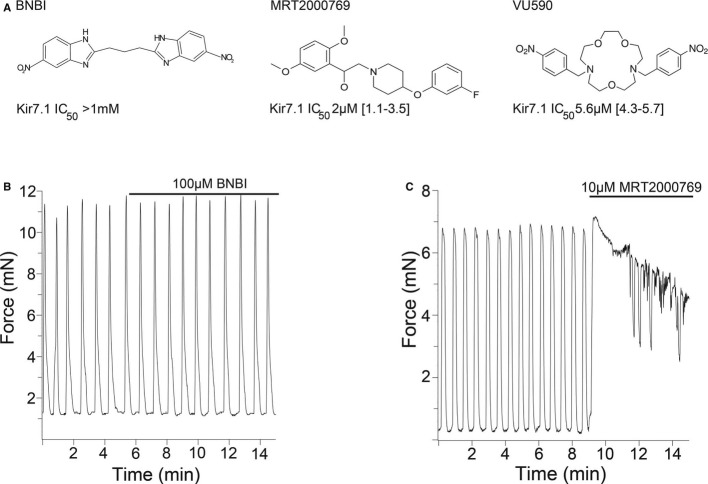
Stimulation of uterine contractions correlates with Kir7.1 inhibitory potencyA The structures of the three compounds tested in this study. BNBI, a potent Kir1.1 inhibitor does not inhibit Kir7.1. MRT2000769 is structurally unrelated to VU590 and was identified as inhibiting Kir7.1 in a high throughput electrophysiology screen. VU590 is the first described inhibitor of Kir7.1.B, C Effects of BNBI (B) and MRT2000769 (C) on murine GD15 myometrial contractility.